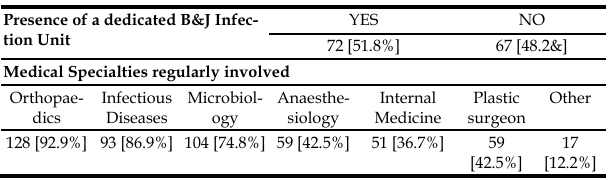
Table 2. Bone & Joint Infection Unit.